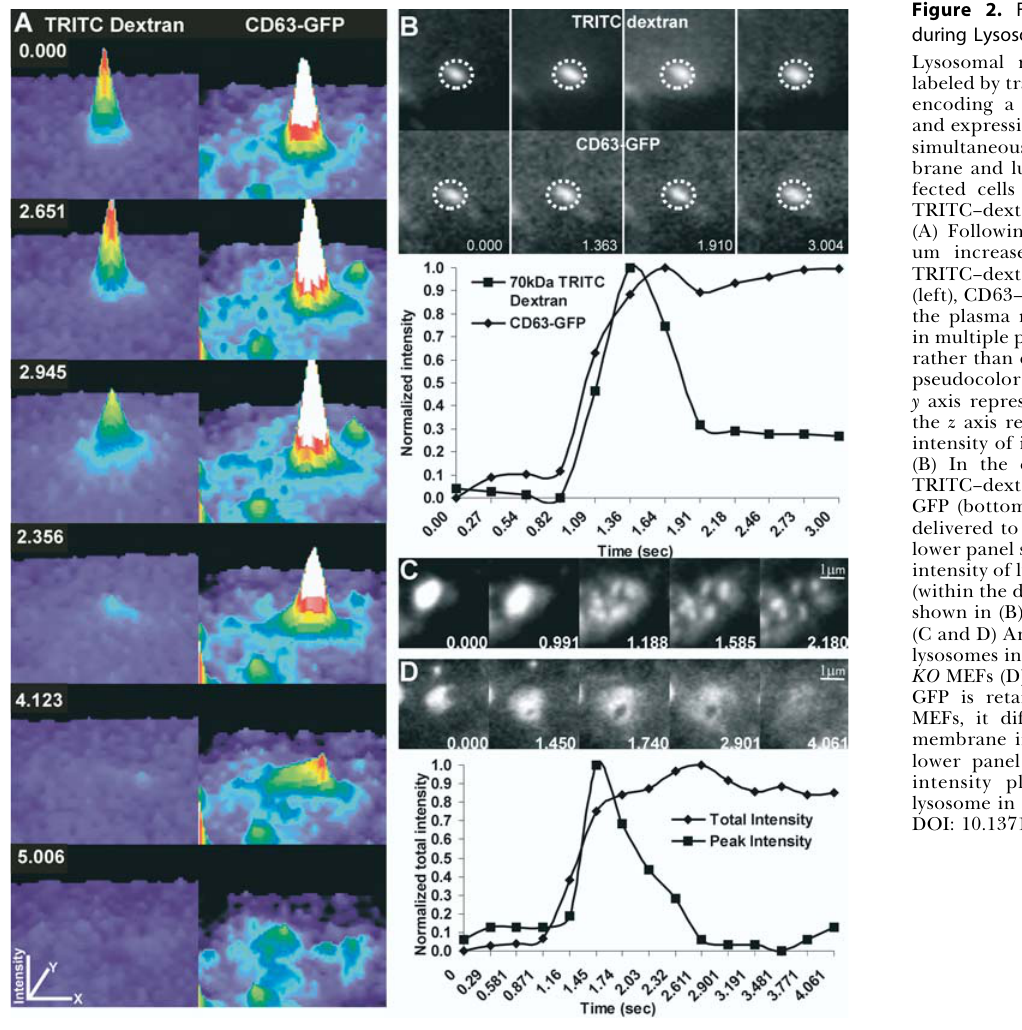
Table 2. Nature of Release of Lysosomal Membrane Protein Cell Number WT MEF Syt VII KO MEF Number of Events Diffused Punctate Number of Events Diffused Punctate